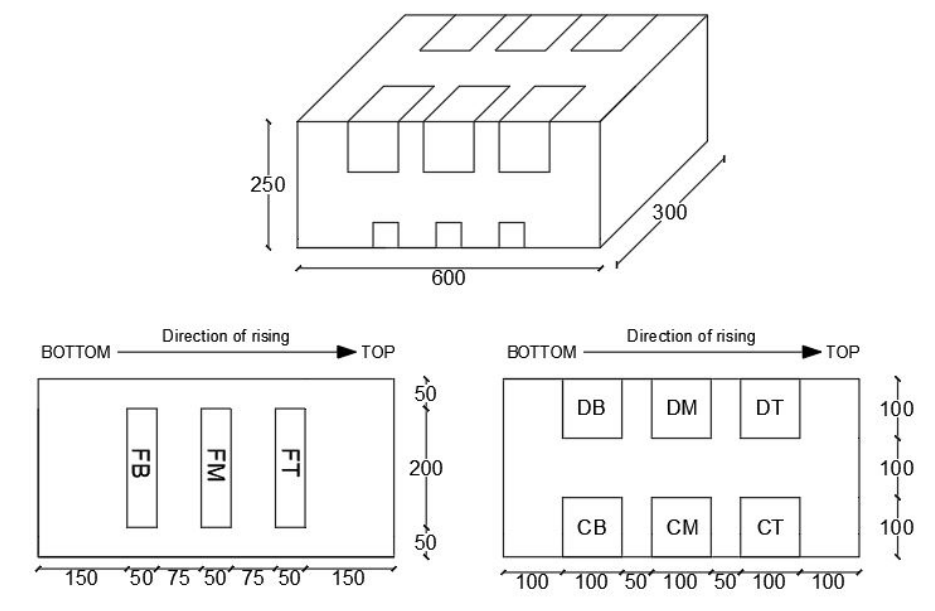
Figure 1. Sampling scheme for compression and flexural